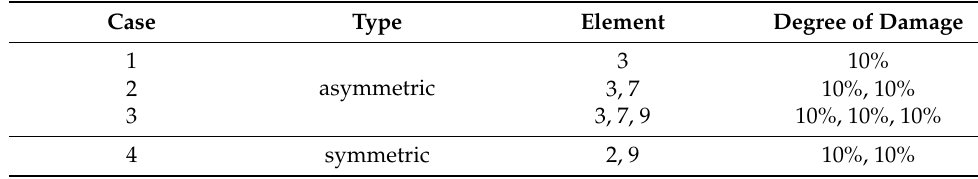
Table 5. Different damage cases of the simply supported